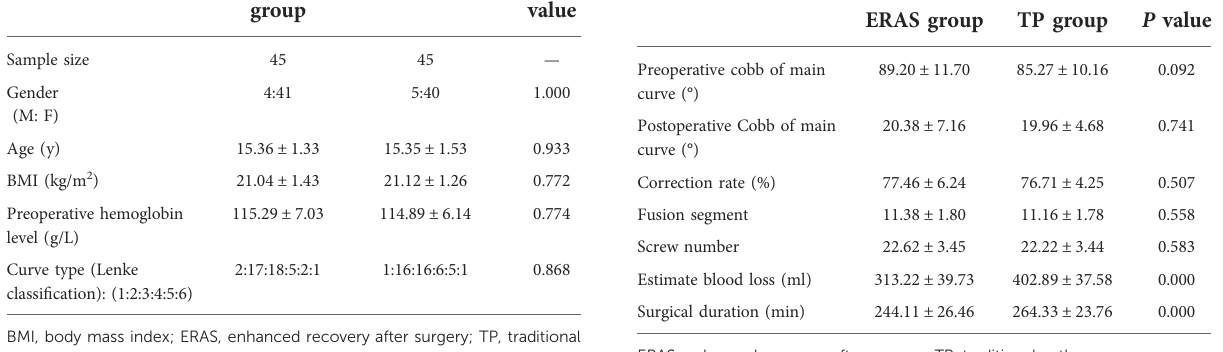
TABLE 3 Surgical information of two